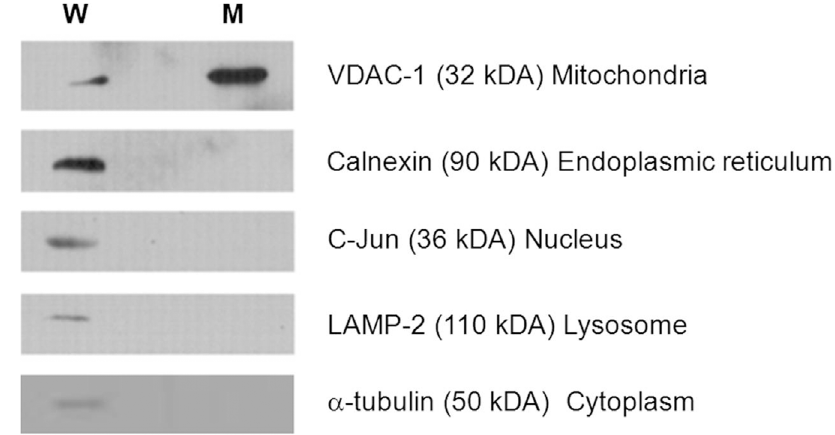
Figure 2. Western blot analyses for assessment of mitochondrial enrichment and purity. 20 m g of mitochondrial lysate and whole cell lysate from fibroblasts were separated by 12% SDS-PAGE gel and checked with specific antibodies against various sub-cellular organelles. (W=whole cell lysate; M=mitochondrial enriched fraction) (The same membrane for each cell type was stripped and probed with subsequent antibodies.).